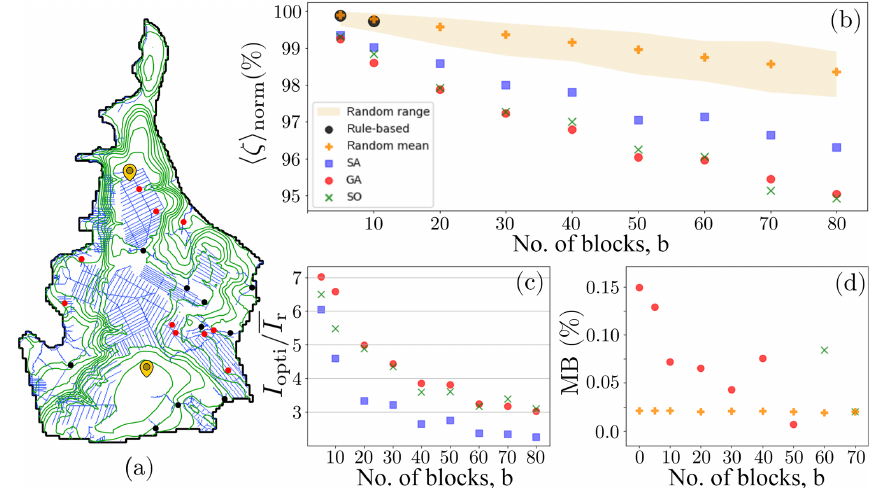
Figure 7. Peat rewetting performance comparison of random block locations, the rule-based approach and the optimization algorithms (SA: simulated annealing; GA: genetic algorithm; SO: simple algorithm) for different numbers of blocks. (a) Map of the area. The canal network is shown in blue, and the contour lines in green. The resulting block positions for the case b = 10, both for GA (red dots) and rule-based (black dots), are shown. Furthermore, the locations of the annual WTD simulations of Fig. 10 are indicated by yellow plectrum-like markers. (b) (cid:104) ζ (cid:105) norm , defined in Eq. (14), as a function of the number of blocks. The rule-based approach was only carried out for 5 and 10 blocks. (c) Relative improvement of several block locating methods with respect to the mean of the random configuration, as defined in Eq. (16), for different numbers of blocks. (d) Marginal benefit, as defined in Eq. (17), for the best performing optimization algorithm and for the mean of the random configurations.